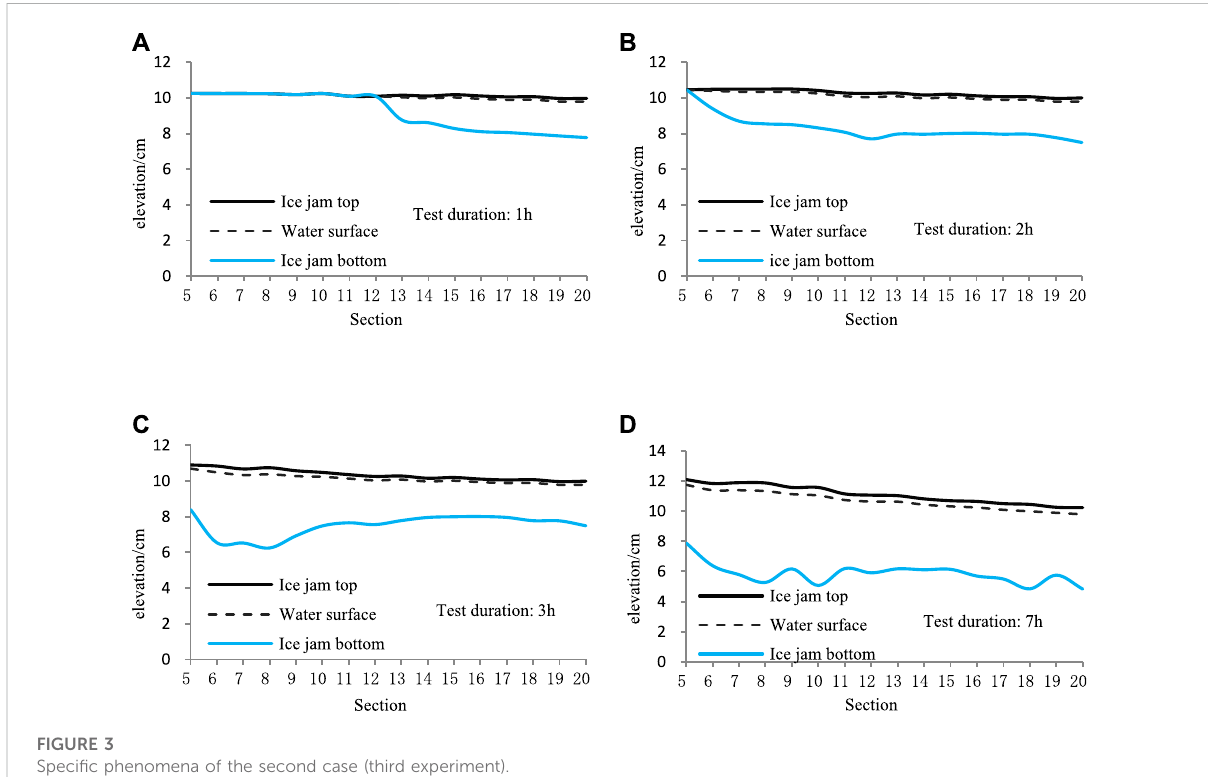
FIGURE 3 Speci fi c phenomena of the second case (third